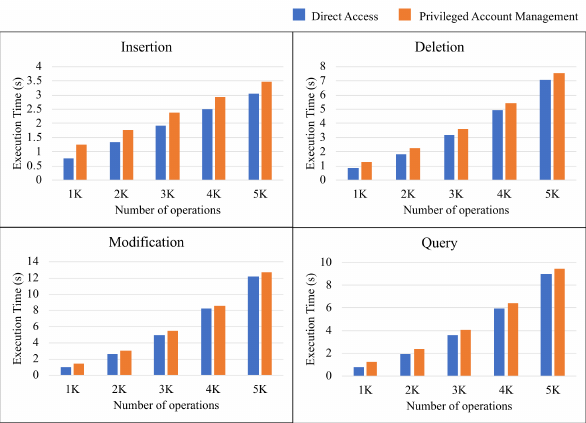
Figure 12. Comparison of execution time between direct access and secure access in scenario 1.